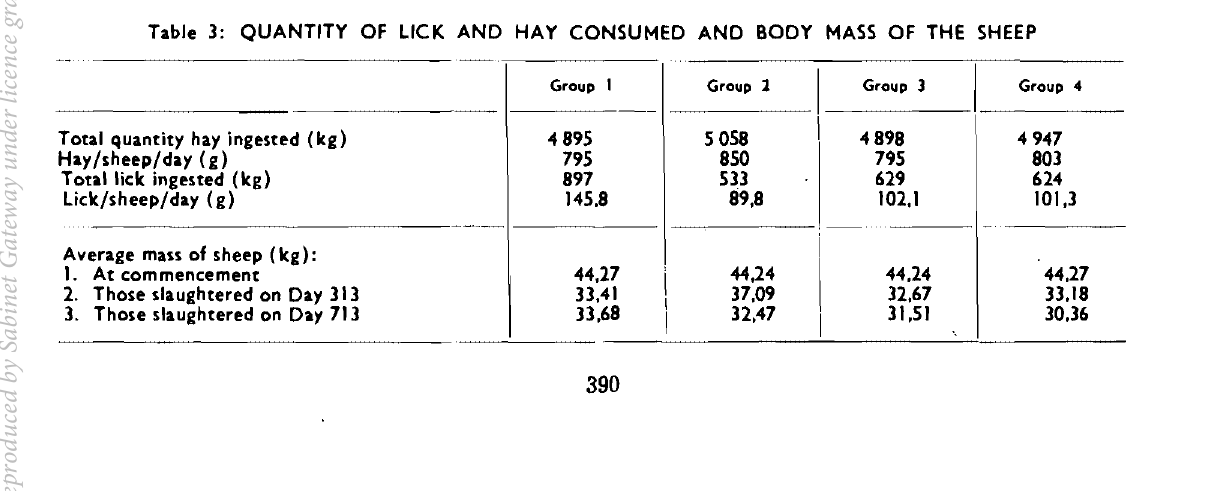
Table 3: QUANTITY OF LICK AND HAY CONSUMED AND BODY MASS OF THE SHEEP --